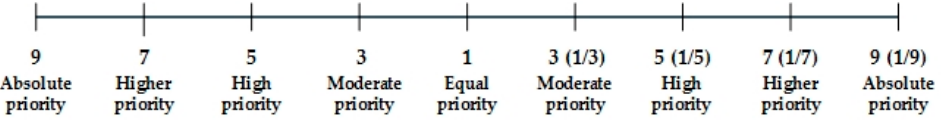
Table 2. AHP scale of importance. Figure 3. An example of a Saaty scale for defining priorities.